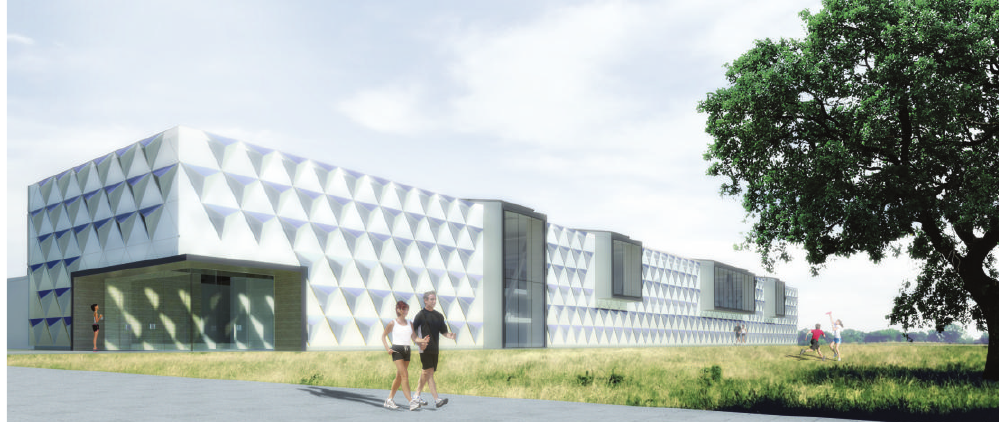
Figure 1: Architectural rendering of the Downsview Plain research and sports building.